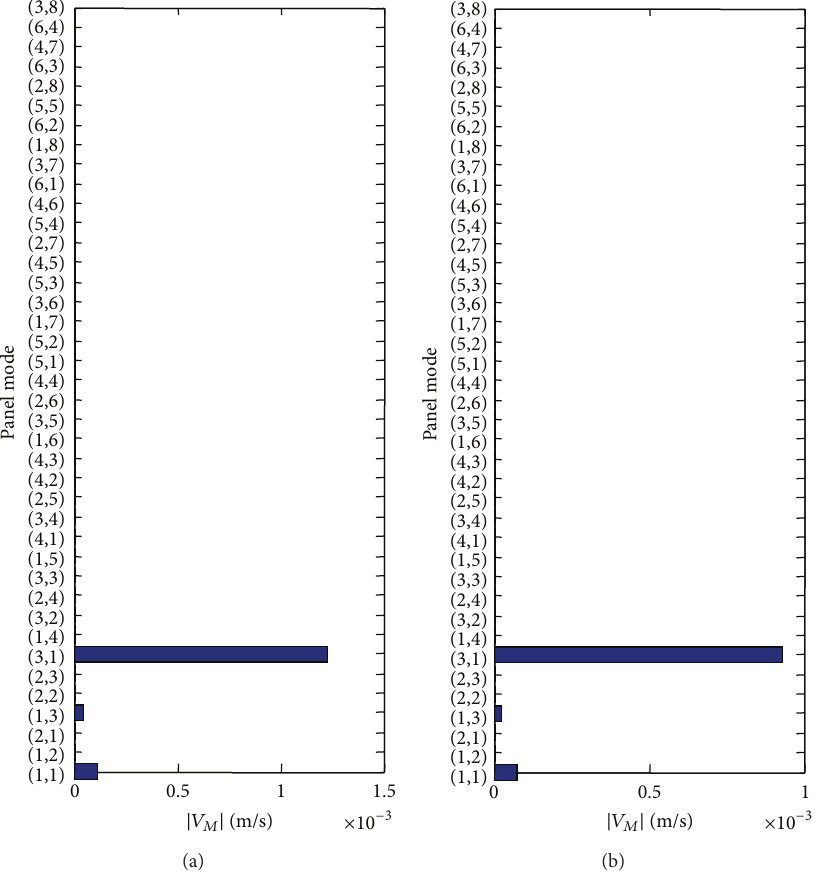
Figure 11: Modal amplitude of panel vibration velocity: (a) the (0,0,1) enclosure-controlled mode; (b) the (3,1) panel-controlled mode. ℎ = = 0.722 m, 𝑇 = 15 s, 𝑇 = 0.5 0.007 m, 𝐿 𝑍 𝑎𝑁 𝑝𝑀